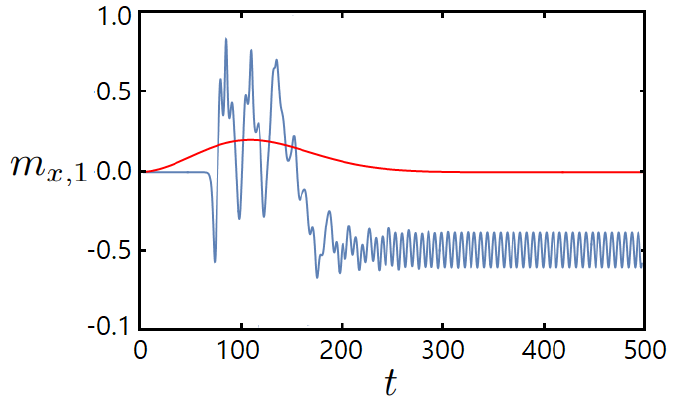
Figure 2: Time evolution of the order parameter of the low-energy sector (blue curve). The red curve corresponds to the envelope E ( t ) of the perturbation, see = 0.20 and τ = Eq. (19), with E 0